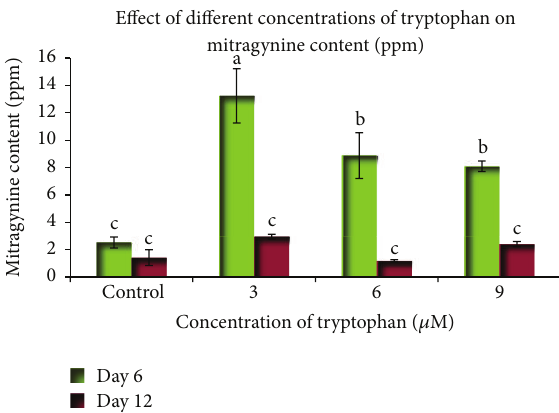
Figure 7: The effect of different tryptophan concentrations at different culture times on the mitragynine content in the suspension cultures of Mitragyna speciosa . The bars indicate standard error. ∗ Valueswiththesamelettersarenotsignificantlydifferentaccording to Duncan’s multiple range test.